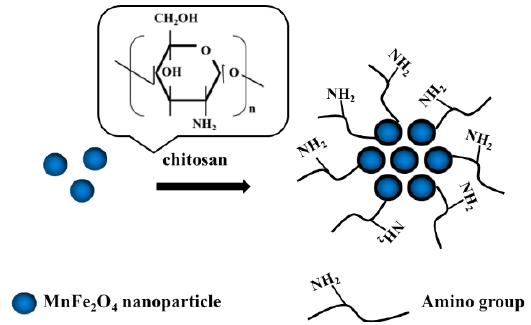
Figure 1. Schematic diagram for fabrication of MnFe 2 O 4 @chitosan.